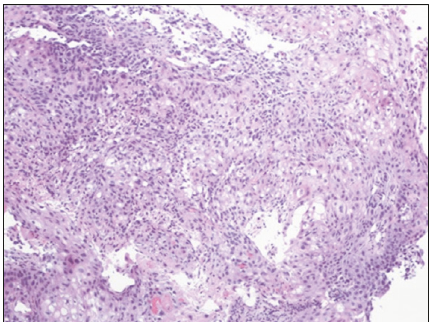
Figure 4: Lymph node pathology. Squamous cell carcinoma com- prised sheets of malignant cells showing nuclear pleomorphism and nuclei (low magnification ×